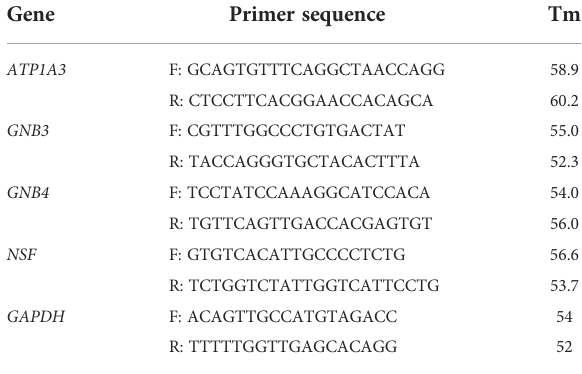
TABLE 1 mRNA-speci fi c primer